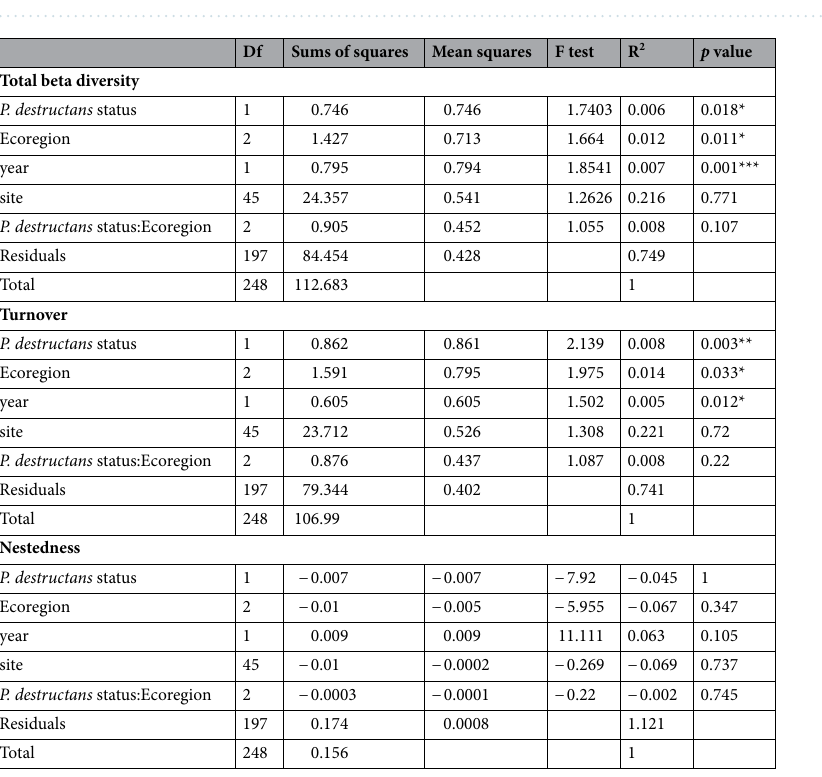
Figure 6. Non-metric multidimensional scaling ordination for. ( a ) P. destructans positive and ( b ) P. destructans negative bats across ecoregions ( a ) stress 0.17; ( b ) stress 0.14. There is a significant effect of P. destructans , year and ecoregion ( p < 0.05), however, there is no significant interaction between P. destructans status and ecoregion. There is significant variation in dispersion across ecoregions for P. destructans negative bats ( b ). Graphs were produced using the ggplot2 package (version 3.3.2) in R 25 .